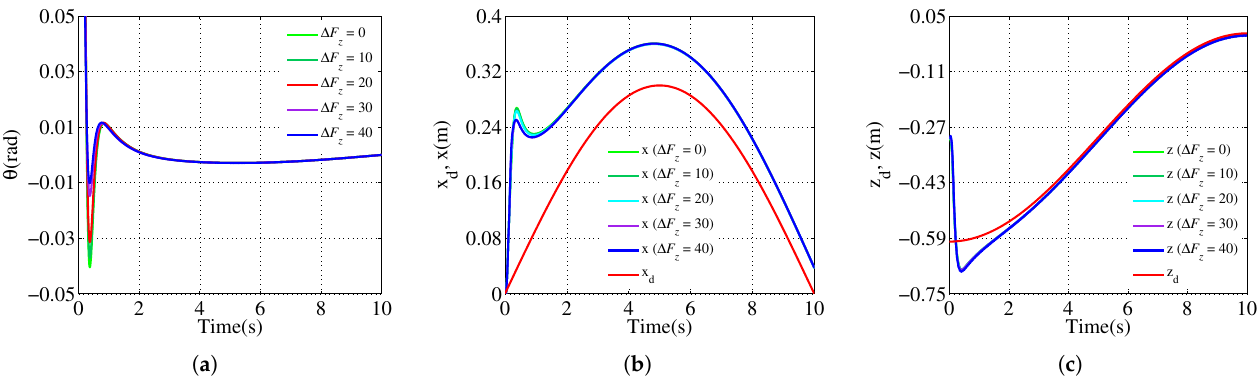
Figure 13. The simulation tests when ∆ F z = 0,10,20,30, and 40. ( a ) The θ ; ( b ) the x d and x ; and ( c ) the z d and z .